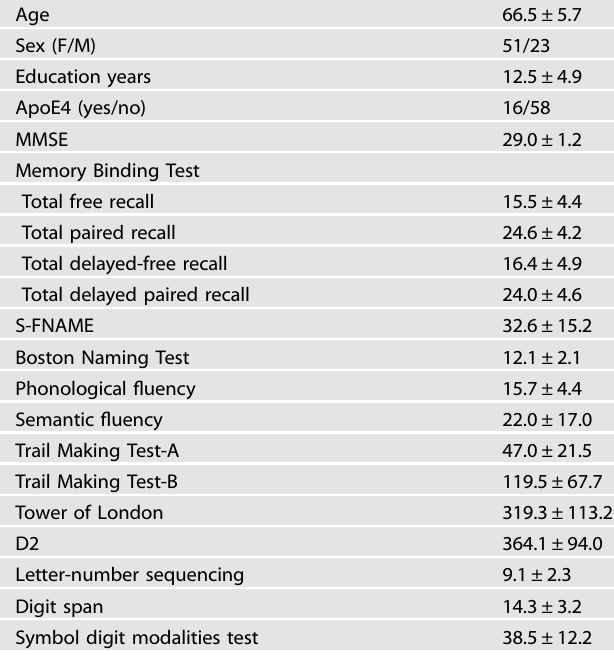
explained 37.7% of variance in the data.